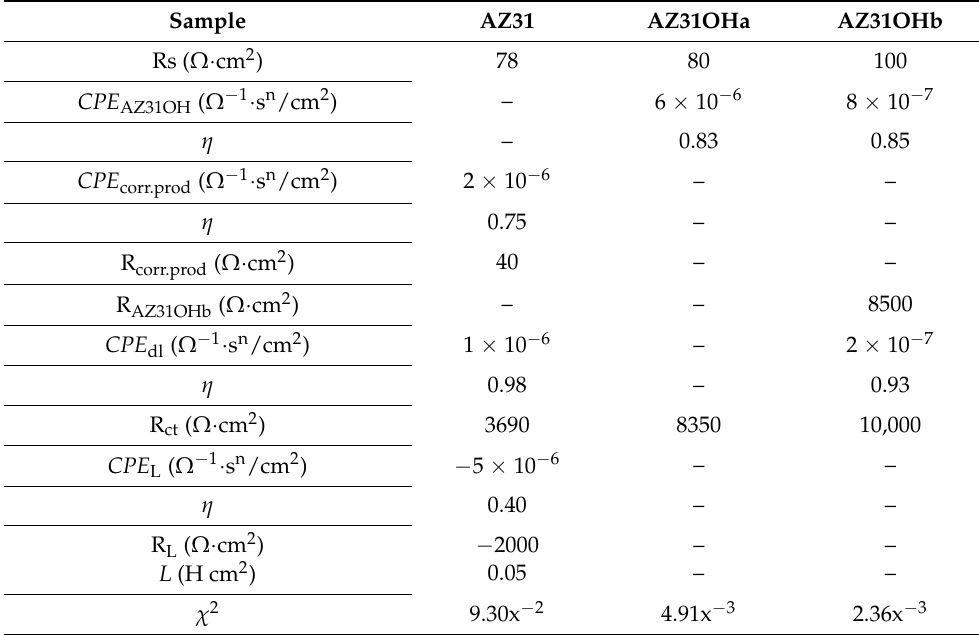
AZ31 exhibited inductive behaviour, as shown in Figure 2a. The inductive loop was correlated with the high surface reactivity of AZ31, and the presence of Cl − ions in HBSS increased their adsorption by AZ31 (increasing metal oxidation), which consumed electrons from adsorption sites [39,40]. The inductive loop exhibited characteristic CPE values associated with AZ31 ( − 5 × 10 − 6 Ω − 1 s n /cm 2 ) but was negative as presented in Table 4. By contrast, the time constant associated with AZ31OHa (passive film) obtained by anodising exhibited CPE values (6 × 10 6 Ω − 6 s n /cm 2 ) was close to those of AZ31 (2 × 10 − 6 Ω − 1 s n /cm 2 ). Therefore, this behaviour can be attributed to the addition of the resistive contribution (the passive film and charge–transfer resistance). Additionally, two constant times were identified for AZ31OHb. The first is associated with the